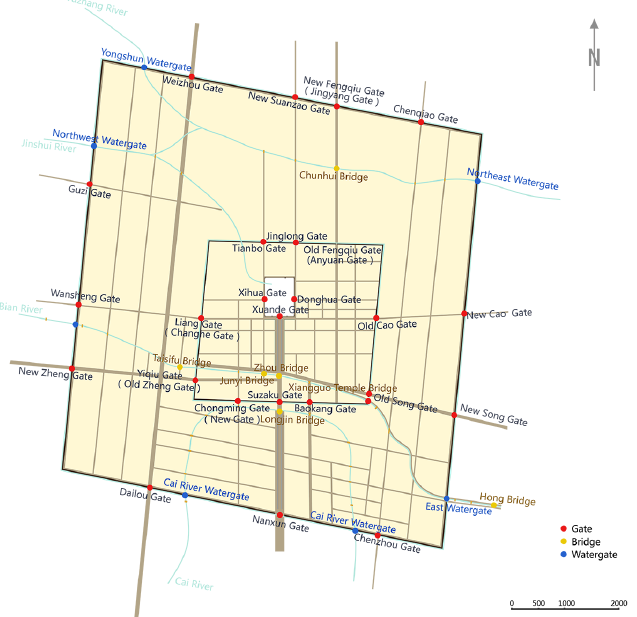
Figure 2. Recovery plan of Dongjing city of the Song Dynasty based on Dongjing Menghua Lu and the papers by Ye et